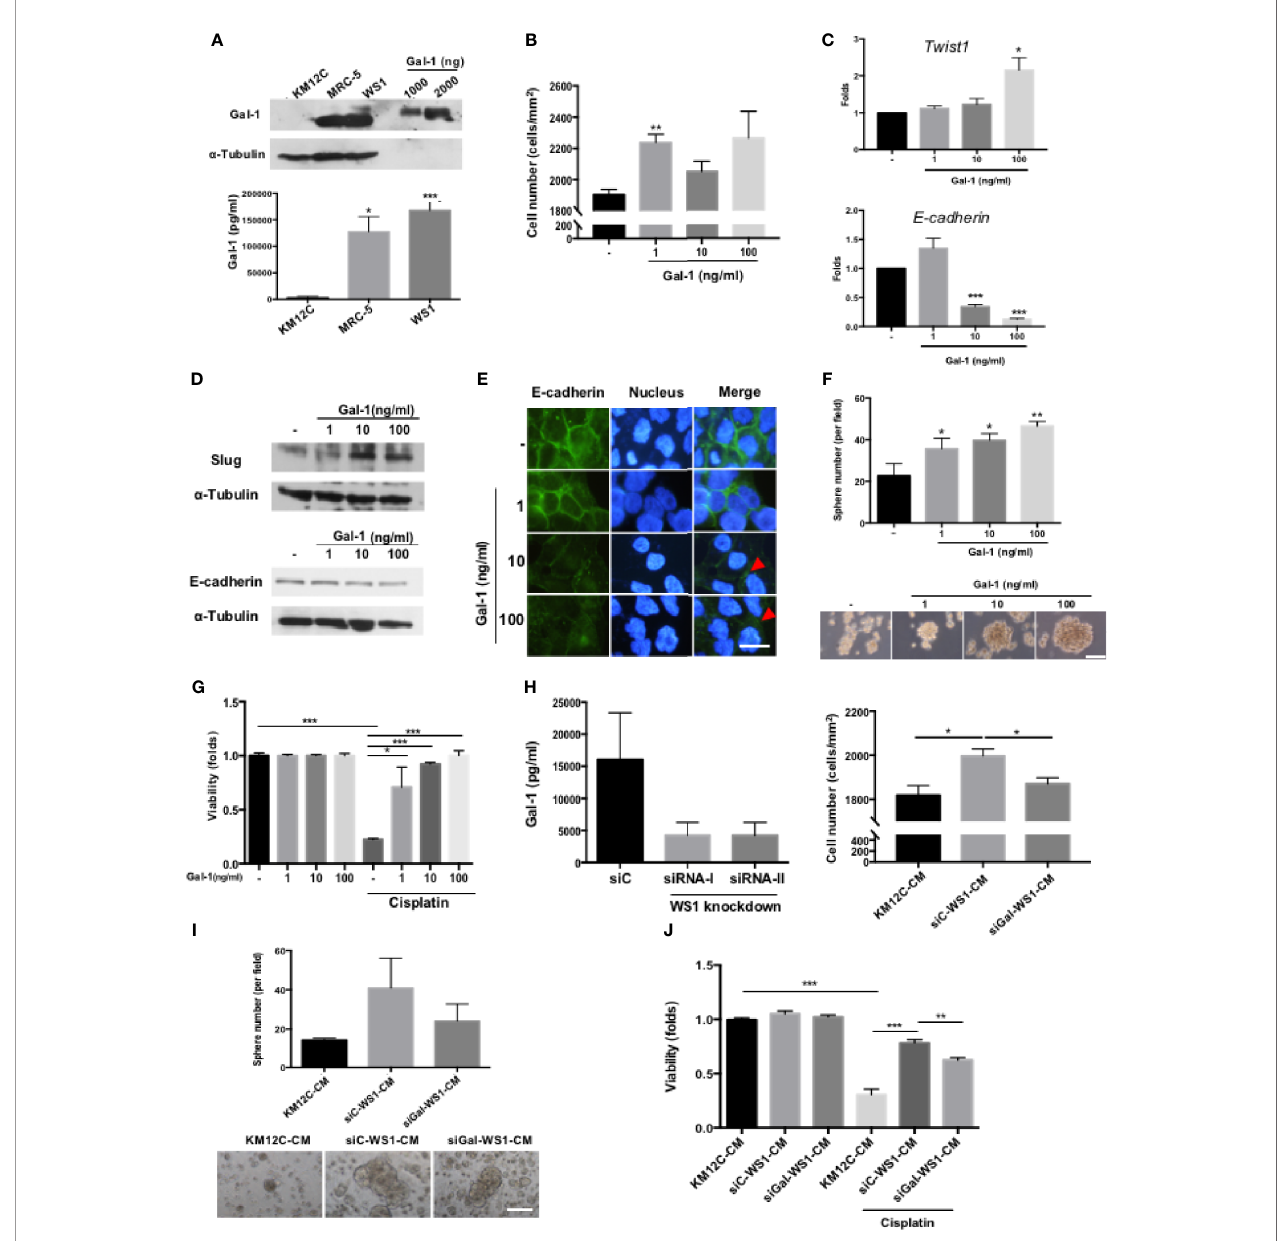
FIGURE 2 | Fibroblast-secreted galectin-1 (Gal-1) signi fi cantly promotes multiple CIC features in CRC cells. (A) Expression of endogenous Gal-1 in MRC-5 and WS1 fi broblasts as detected through Western blot (top panel; recombinant human Gal-1 protein (rhGal-1) used as positive control) and ELISA (bottom panel). (B) Invasion capacity of KM12C with the addition of increasing doses of rhGal-1. (C) qPCR analysis for the gene expression of Twist1 and E-cadherin and (D) Western blot for protein expression of Slug and E-cadherin in KM12C with the addition of increasing doses of rhGal-1. (E) IF staining of E-cadherin (green fl uorescence) in KM12C with the addition of increasing doses of rhGal-1 for 48 hours. Nuclei were stained with Hoechst 33342 (blue fl uorescence); scale bar, 10 m m. (F) Sphere formation capacity of KM12C with the addition of increasing doses of rhGal-1; quantitative results (top panel) and representative images (bottom panel) are shown; scale bar, 30 m m. (G) Drug resistance capacity of KM12C to cisplatin (25 µM) after pretreatment with increasing dosages of rhGal-1 for 24 hours. Cell viability was assessed 48 hours after drug treatment. (H) Left panel: Validation of Gal-1 knockdown using small interfering RNA (siRNA) speci fi c for Gal-1 (siRNA-I & siRNA-II) in WS1 fi broblasts. Non-target siRNA was used as a negative control. After 48 hours, CM from siRNA-I, siRNA-II, and siC were removed and analyzed by ELISA. Right panel: Invasion capacity of KM12C after culturing in siGal-WS1-CM compared to siC-WS1-CM for 48 hours. (I) Sphere formation capacity of KM12C cultured in KM12C-CM, siC-WS1-CM, or siGal-WS1-CM for 72 hours; quantitative results (top panel) and representative images (bottom panel) are shown; scale bar, 30 m m. (J) Drug resistance capacity of KM12C to cisplatin (25 µM) after pretreatment with KM12C-CM, siGal-WS1-CM, or siC-WS1-CM for 24 hours. Cell viability was assessed 48 hours after drug treatment; control, KM12C without cisplatin treatment. All results are shown as the mean ± SEM of three independent experiments. * p < 0.05; ** p < 0.01, and *** p < 0.005 compared to the